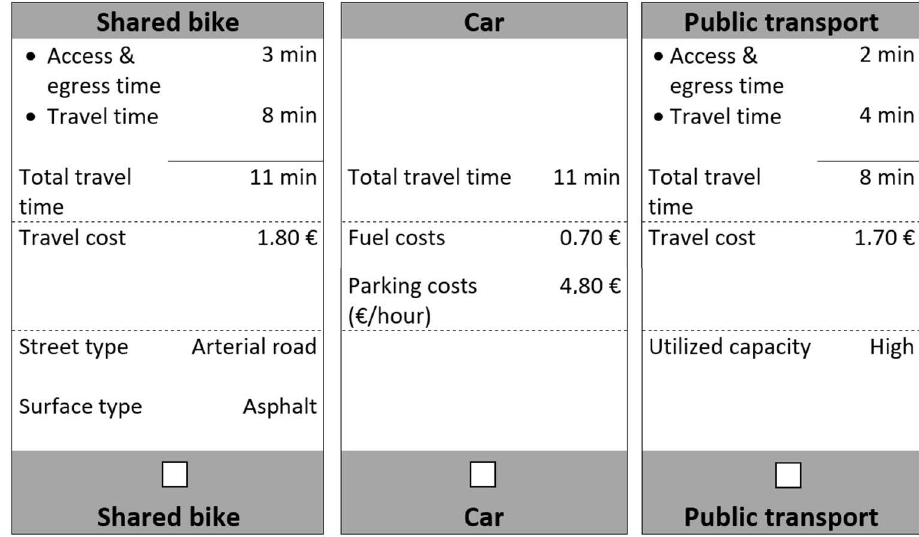
Figure 5. Example of a choice task.